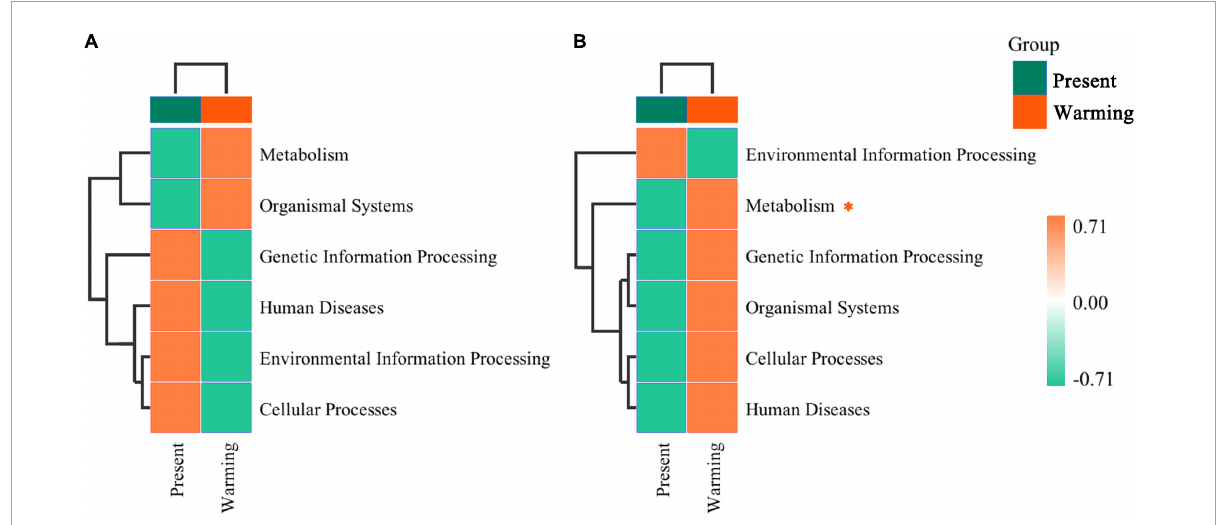
FIGURE6 The hierarchical clustering of functional classifications in microbiota at top level between present and warming of Eremias argus (A) and Takydromus amurensis (B) . The horizontal ordinate represents the sample information and species annotation information; the cluster trees on the left and the top are species clustering and sample clustering, respectively. Gradient colors indicate the regulation of the warming climate against the present climate. ∗ Asterisk indicates a significant difference between present and warming climate conditions ( P <